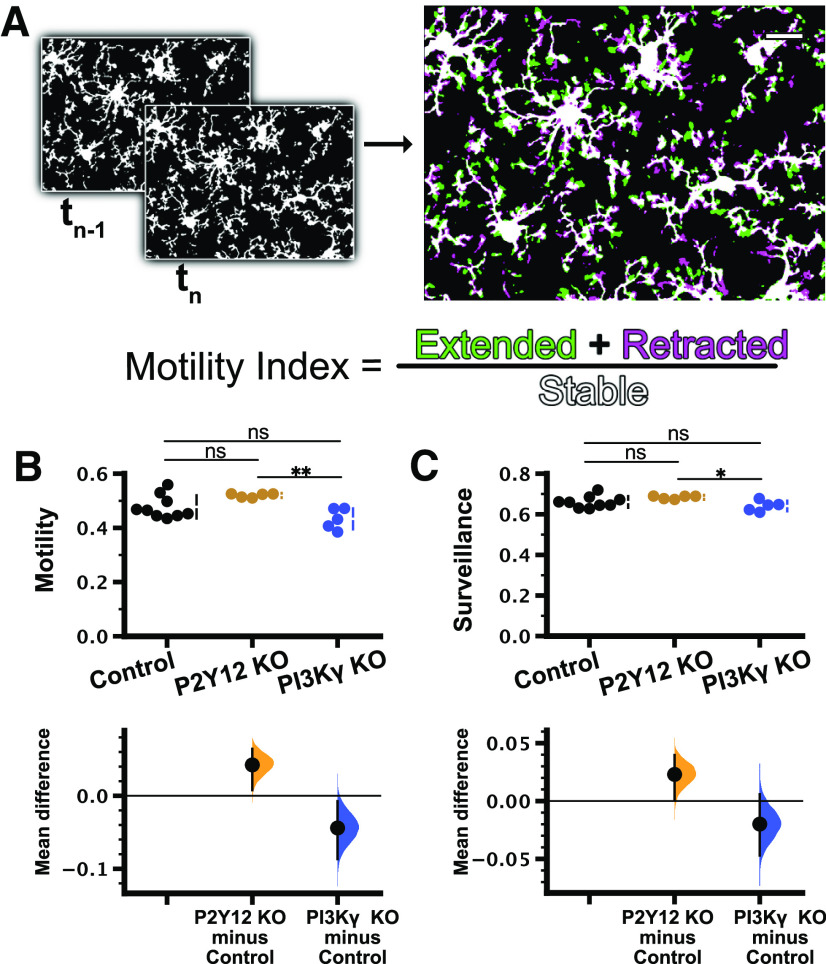
Microglial motility and surveillance were not affected in PI3Kγ KO mice. A, Schematic illustrating the generation of the microglial motility index from time-lapse imaging (see Materials and Methods). B, C, Cumming estimation plots were used to show the mean differences between controls and experimental groups. B, Motility in control mice was not significantly different from that in P2Y12 KO or PI3Kγ KO mice, but significant differences were observed between P2Y12 KO and PI3Kγ KO groups (one-way ANOVA, p = 0.0060; Tukey’s test: control vs P2Y12KO p = 0.12; control vs PI3Kγ KO p = 0.10; P2Y12 KO vs PI3Kγ KO p = 0.0043). Cumming estimation plot shows mean differences (lower axes) between controls and experimental groups [P2Y12 KO 0.0423 (95%CI 0.00771, 0.0642); PI3Kγ KO −0.0441 (95%CI −0.0867, −0.00742)]. C, Similar to motility, surveillance in the control group was not different from that in either P2Y12 KO or PI3Kγ KO, but the surveillance of PI3Kγ KO microglia was lower than P2Y12 KO microglia (one-way ANOVA, p = 0.043; Tukey’s test: control vs P2Y12KO p = 0.24; control vs PI3Kγ KO p = 0.34; P2Y12 KO vs PI3Kγ KO p = 0.034). Mean differences versus controls shown in Cumming estimation plot [P2Y12 KO 0.023 (95%CI 0.00123, 0.0398); PI3Kγ KO −0.0199 (95%CI −0.0471, 0.00586)]. n (animals) = 9 control; 5 P2Y12 KO; 5 PI3Kγ KO); ns, non-significant; *p < 0.05, **p < 0.01. Data are presented as mean ± SEM. Scale bar: 20 μm.